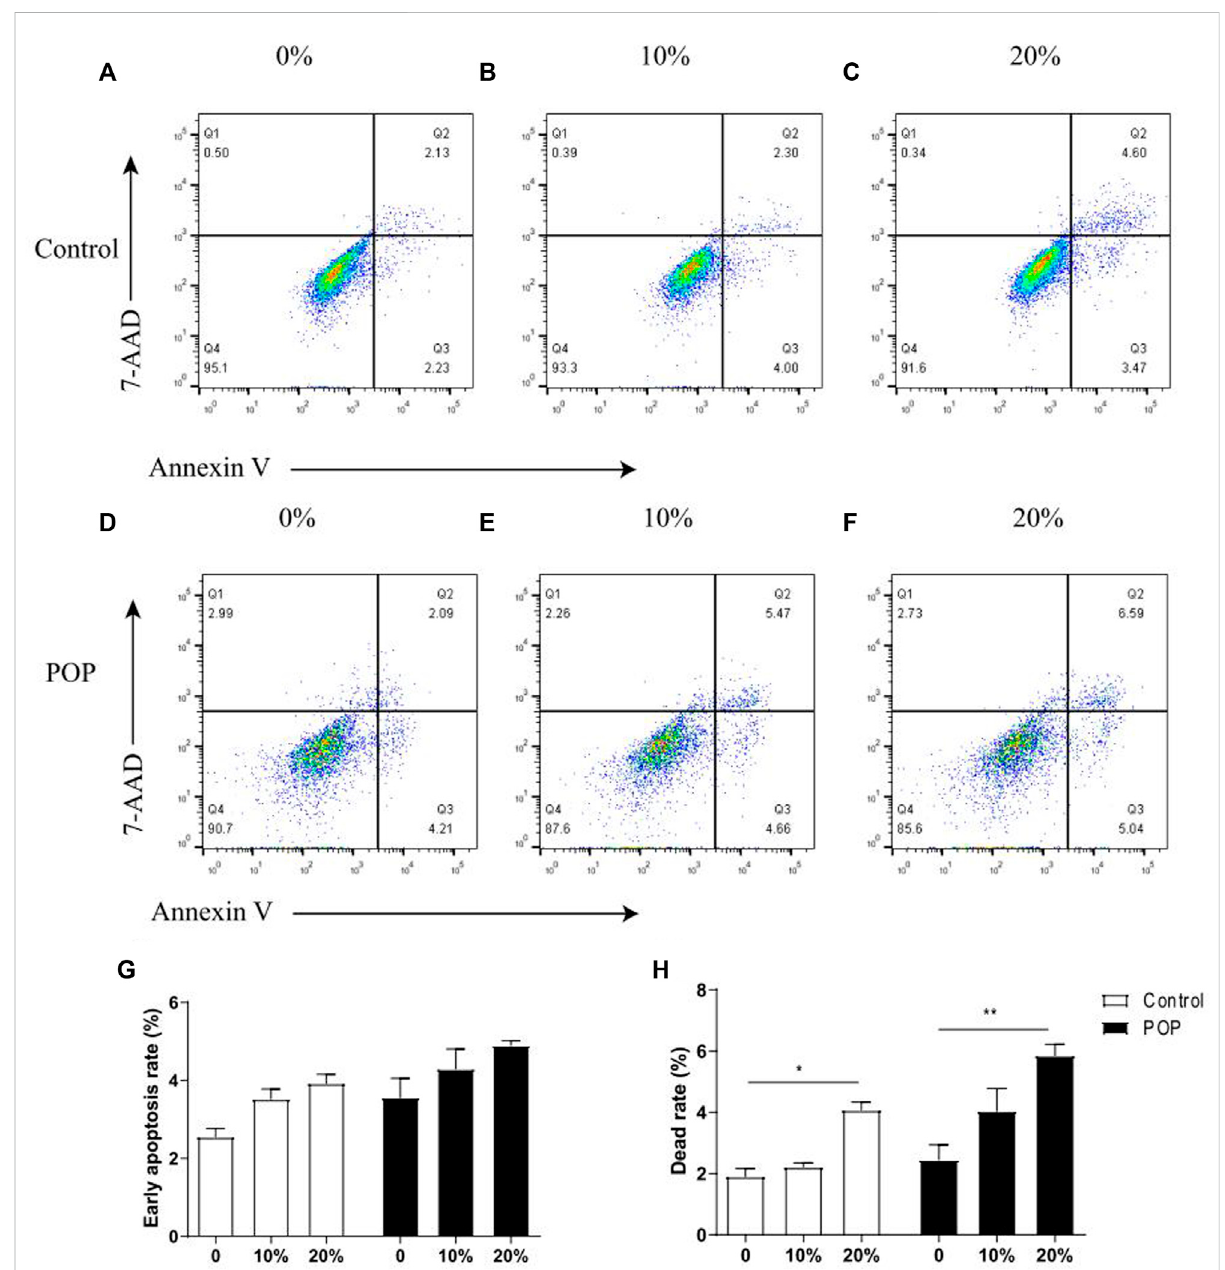
FIGURE 3 Mechanical stress induced apoptosis of hUSLFs occurs in a loading-dependent manner. (A) Representative dot plots of cell apoptosis by fl ow cytometry analysis after Annexin V/7-AAD dual staining. The apoptotic rate was determined as the percentage of 7-AAD negative and Annexin V positive (Q3). Cells that are already dead are both Annexin V and 7-AAD positive (Q2). (A,D) control; (B,E) 10% strain, 0.5 Hz; (C,F) 20% strain, 0.5 Hz. (G) Quanti fi ed apoptotic rates of hUSLFs treated with various intensities of mechanical strains for 24 h. (H) Quanti fi ed dead rates of hUSLFs treated with various intensities of mechanical strains for 24 h. Values are expressed as the mean ± standard deviation of three independent experiments. * p < 0.05; *** p < 0.001 vs.